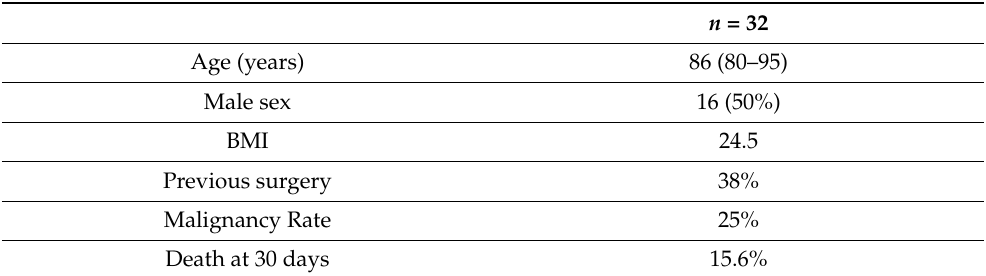
Table 1. Demographic data. Patients treated in emergency surgery for colon diseases. Data are expressed as mean, or percentage